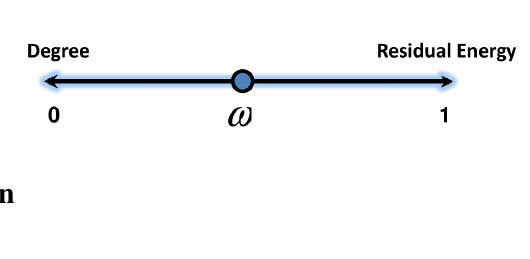
Figure 5. The effect of weight factor ( ω ) on the